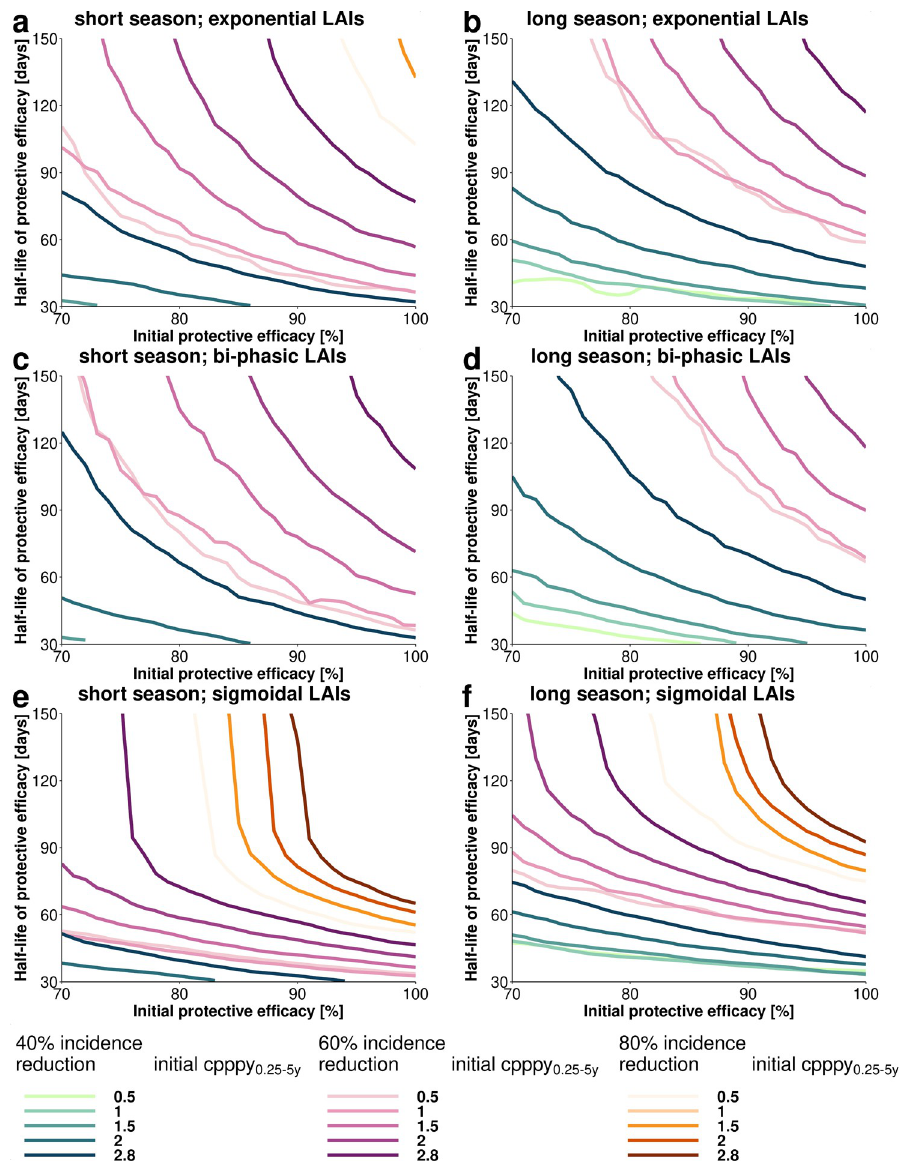
Fig 3. Achieving targeted malaria incidence reduction depends on the decay shape of the LAIs protective efficacy. Estimated relationships between initial protective efficacy and efficacy half-life for different incidence reduction criteria (40%, 60% and 80%, line style and color) and clinical incidence settings (increasing color intensity indicates an initial clinical incidence measured in cases per person per year in the target age group of 0.5, 1, 1.5, 2, and 2.8). Each line shows the minimum required LAI characteristics to reach the desired health goal at a 100% LAI deployment coverage at clinical trial stage , with all parameter combinations below a line failing to meet those requirements. The panels show the parameter space of attainable incidence reductions within the specified constrained ranges of initial protective efficacy and half-life for exponential LAIs (a, b), biphasic LAIs (c, d) and sigmoidal LAIs (e, f) in settings with a short (Senegal-like a, c, e) or long (Mali-like b, d, f) malaria season. The incidence reduction was calculated by comparing the incidence over one transmission season after application of the LAI compared with the previous transmission season. The incidence reductions were obtained by predicting the cases per person per year 0.25-5y via our emulator approach (See S1 Text) in a fine grid defined over the parameter space (increments of 0.1 h for half-life and 0.01% for initial protective efficacy) and calculating the incidence reduction by comparison to the initial clinical incidence measured in cases per person per year 0.25-5y in the respective transmission intensity setting.